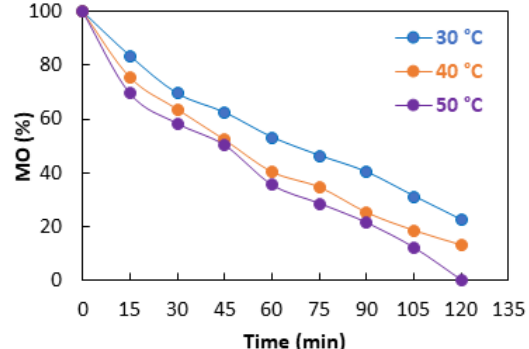
O catalyzed photo 3 4